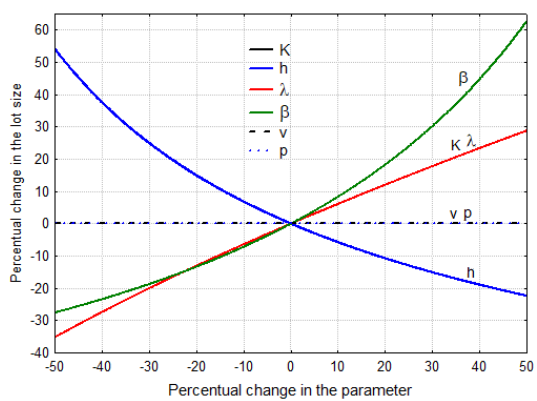
Figure 2. Percentual changes in q ∗ .